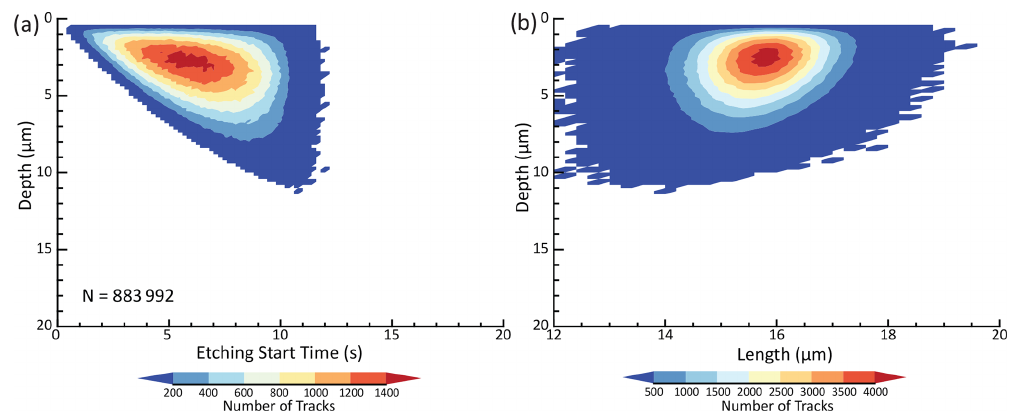
Figure 11. Contour diagrams of model predictions of unannealed induced fission tracks selected by the analyst for measurement after etching the grain mount for 20s. The selected tracks are the subset of the total population of confined tracks shown in Fig. 7b with tips that are sufficiently etched according to analyst criteria. The time–depth contours (a) indicate that, for this model, selected tracks began etching an average of ∼ 6 . 5s after etching commenced and thus etched for an average of ∼ 13 . 5s before being measured. The contours of length versus depth (b) indicate that etched tracks are on average slightly shorter with increasing depth below the polished surface, as on average they have had less time to